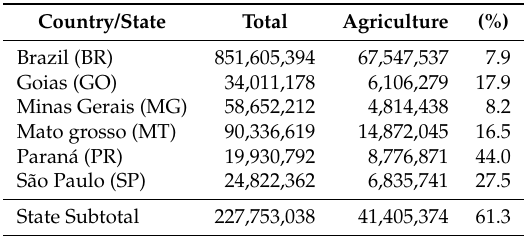
Table 1. Studied areas (ha).